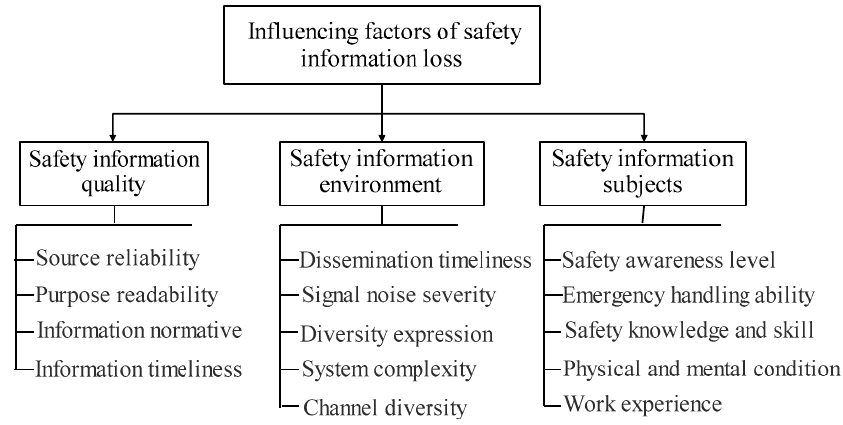
Figure 1. Influencing factors of safety information loss.